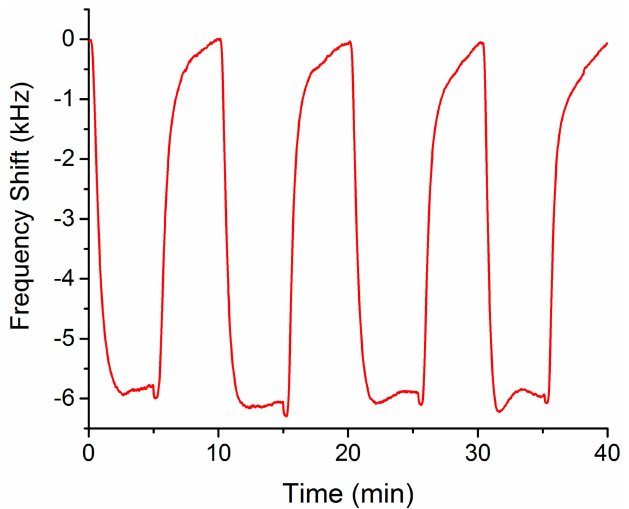
Figure 5. Real time response of the Love-wave sensor for four repetitions of 100 ppm of xylene, as a control